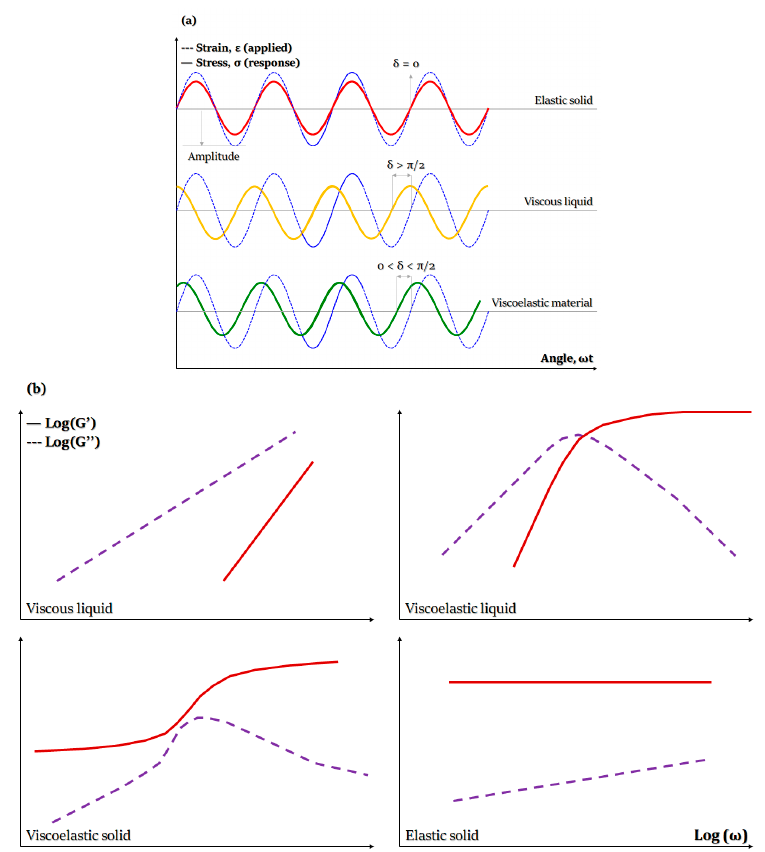
Figure 5. ( a ) Typical stress versus strain response for different materials during oscillatory measurements: viscous liquid, viscoelastic material and a perfectly elastic solid. ( b ) Typical behavior of the storage modulus (G’) and loss modulus (G”) as a function of frequency during dynamic mechanical testing. The values in this figure are not displayed in scale.